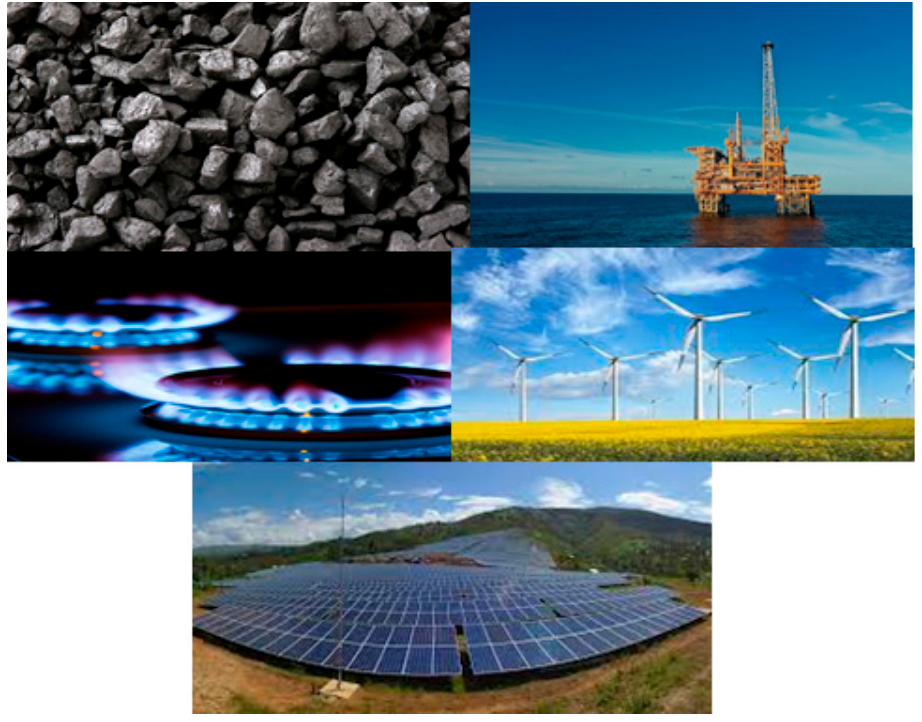
Figure 1. Different energy resources.